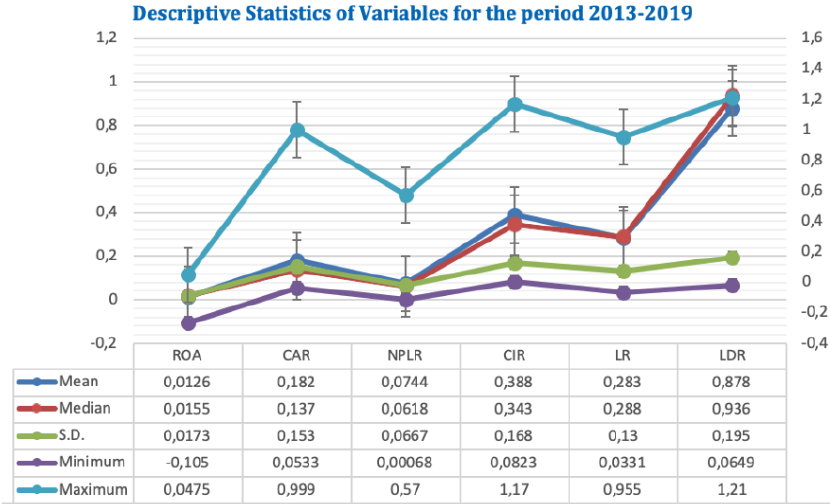
Figure 1: Descriptive Statistics of Variables for the period 2013-2019; Source: Researchers’ Calculation using GRETL In addition, figure 1 shows that cost-to-income ratio (CIR) has a mean of 0.388 implying that the average operating cost is